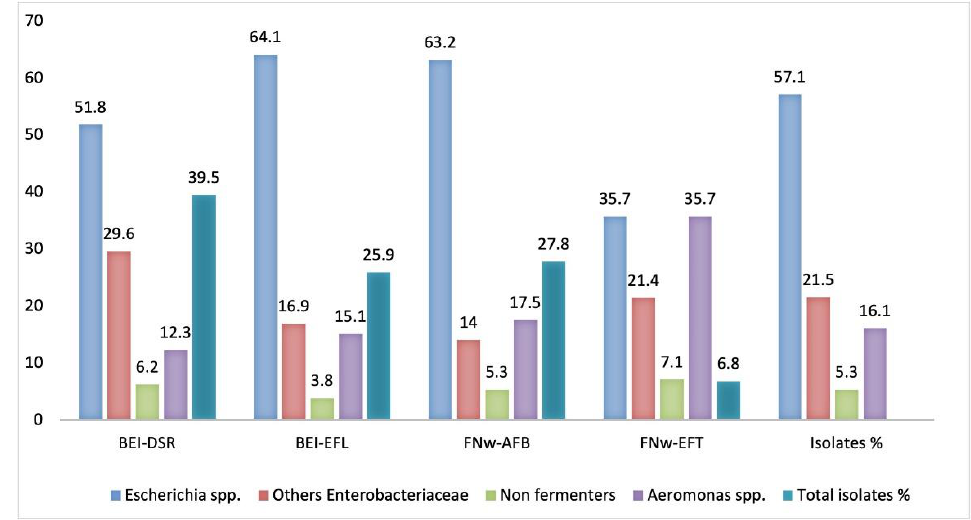
Figure 5. Frequency (%) of the 205 wastewater isolates by taxonomic identity: Escherichia spp., other Enterobacteriaceae , non-fermenter bacteria, and Aeromonas spp., from the Beirolas (BEI-DSR/EFL) and Faro (FNw-AFB/EFT) WWTPs. BEI-DSR: Beirolas-Lisboa influent wastewater; BEI-EFL: Beirolas-Lisboa effluent wastewater; FNw-AFB: Faro Northwest-Algarve influent wastewater; FNw-EFT: Faro Northwest-Algarve effluent wastewater.